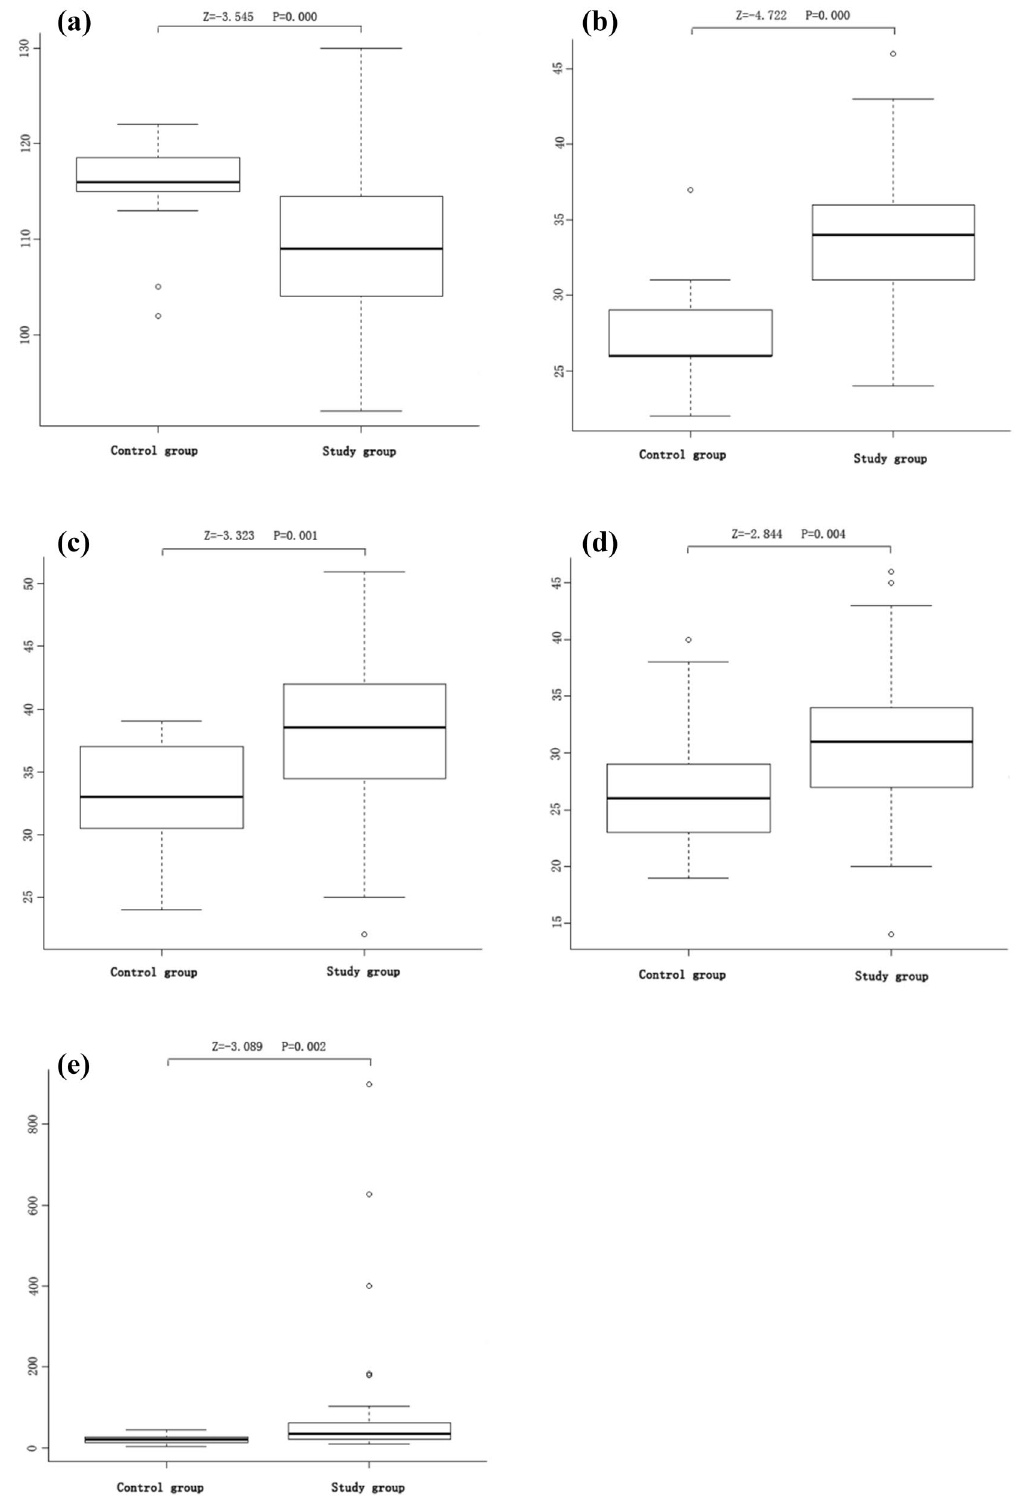
Figure 2. Comparison of psychological stress level and cortisol level between control and study groups after propensity matching. ( a ) The level of quality life among PLWH and people without HIV, ( b ) The level of anxiety among PLWH and people without HIV. ( c ) The level of perceived stress among PLWH and people without HIV. ( d )The level of psychological resilience among PLWH and people without HIV. ( e ) The level of cortisol among PLWH and people without HIV. Note: The box-plots were created via R package